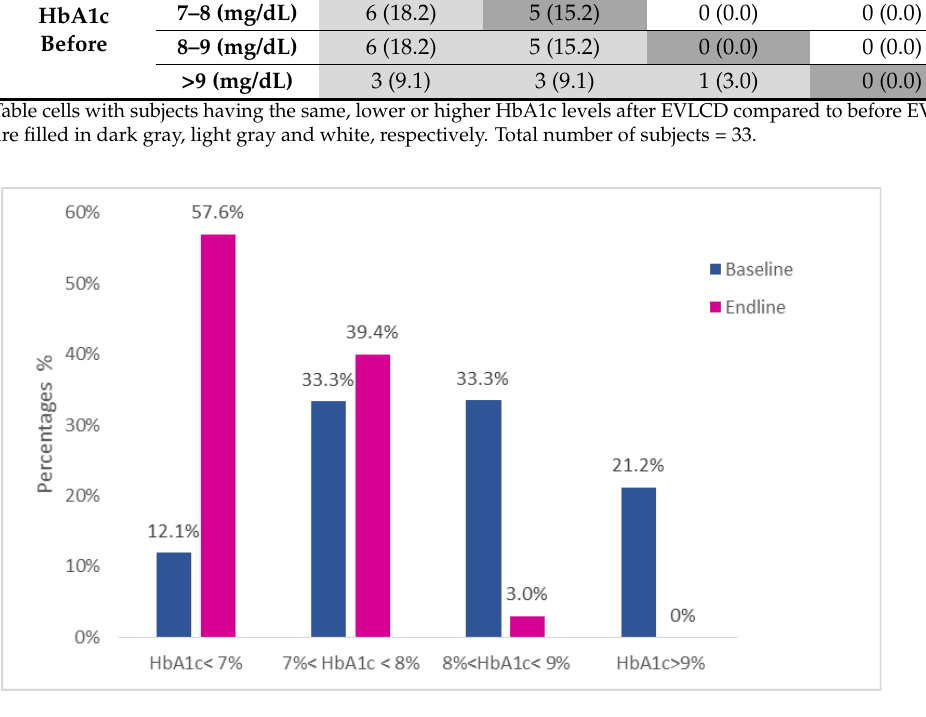
Table 3. Number and percentage of subjects by HbA1c before and after the EVLCD. HbA1c After N (%) <7 (mg/dL)